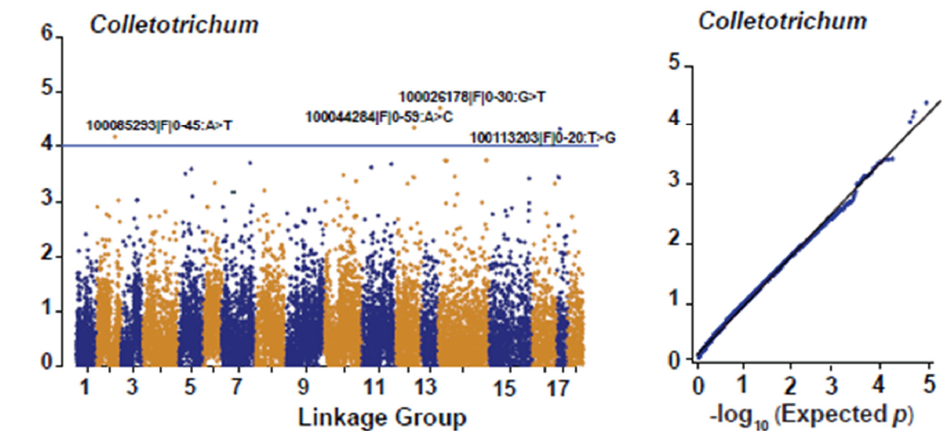
Figure 5. Manhattan plots and quantile-quantile plots from marker-trait association analysis for Phytophthora , Corynespora, and Colletotrichum resistance traits. In the Manhattan plots ( a ), each dot represents an SNP, showing the significance of its association with disease resistance ( − log 10 p -value) (vertical axis) plotted against its genetic position (horizontal axis), and the horizontal blue lines indicate the genome-wide significance threshold of p = 1.0 × 10 − 4 . In the quantile-quantile plots ( b ), the black line represents the 95% confidence limit under the null hypothesis of no-marker-trait association, and the black dots represent p -values.